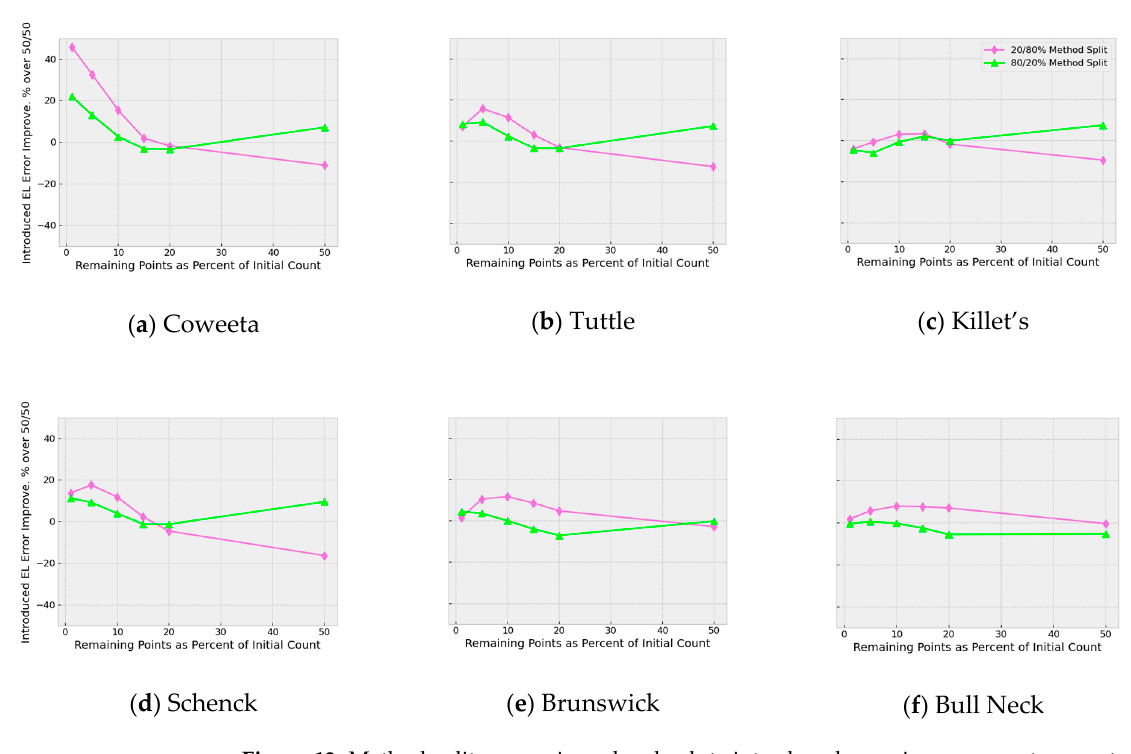
Figure 13. Method split comparisons by absolute introduced error improvement percent.